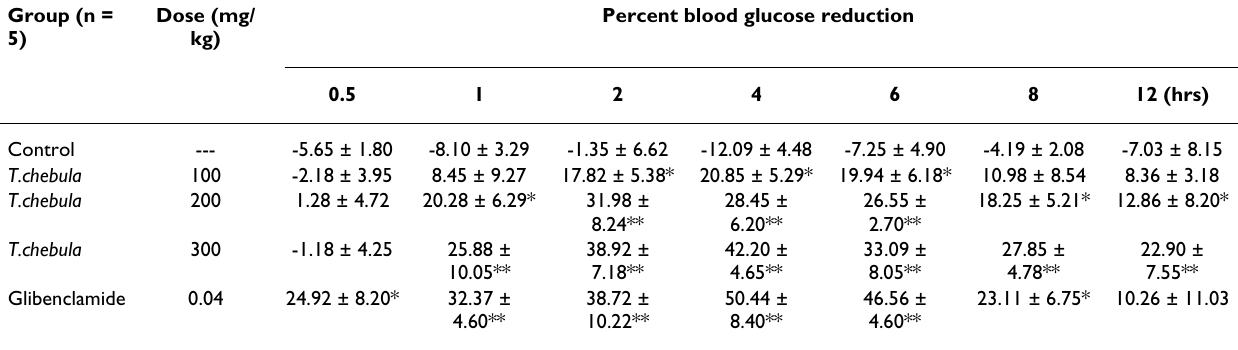
Values are represented as mean ± SEM.; n = number of animals per group Significant difference from control group at identical times, *P < 0.01; **P <